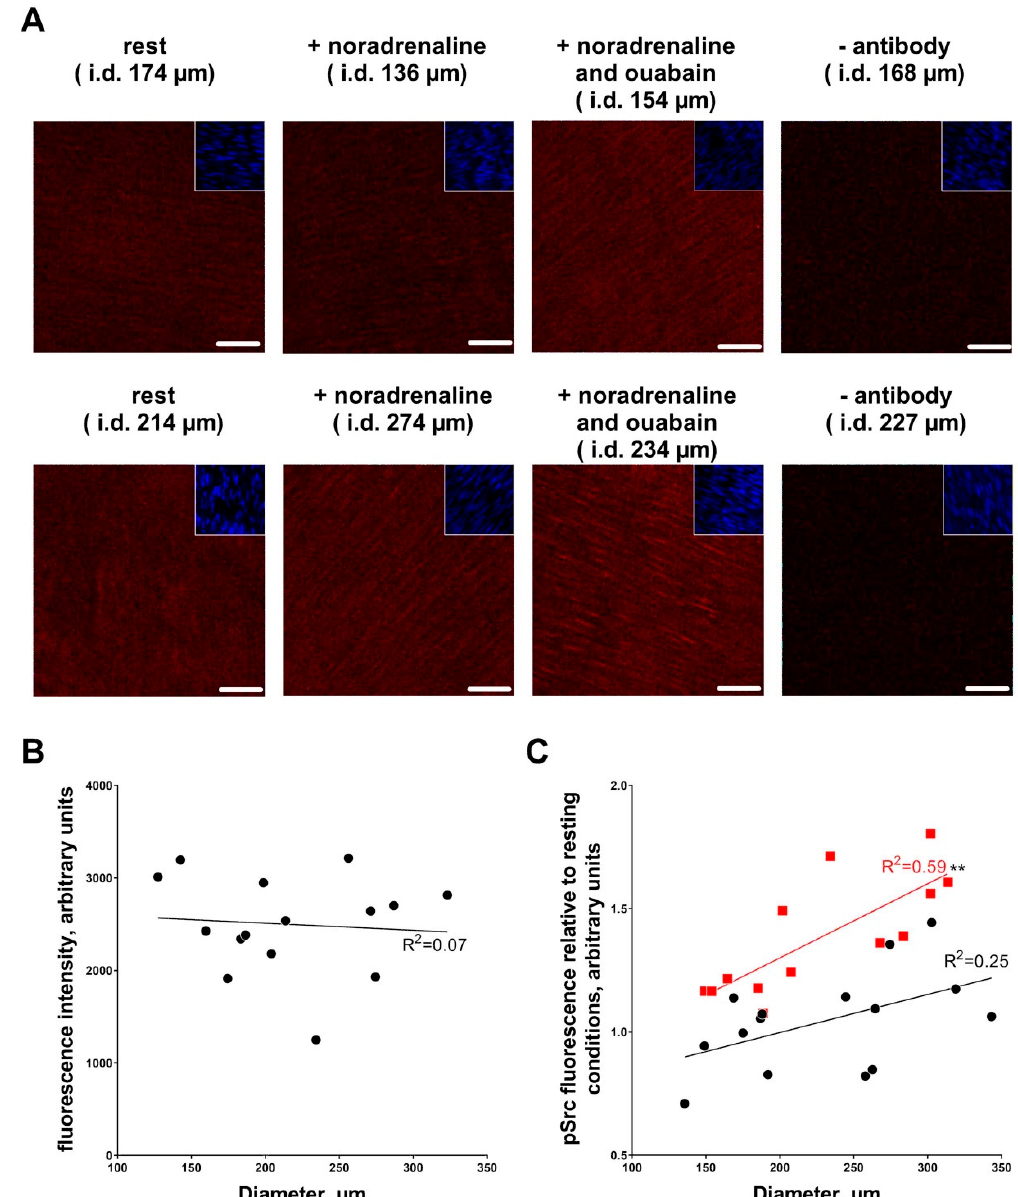
Figure 6. Ouabain-induced phosphorylation of Src kinase increases with arterial diameter. Arteries were fixed at resting conditions, after stimulation with 1 µM noradrenaline or incubation with 10 µM ouabain with the following 1 µM noradrenaline stimulation, as indicated in representative images (( A ); bars indicates 20 µm). A phosphorylated Src (pSrc) related fluorescence intensity was measured in smooth muscle layer in the vascular wall, as indicated by SYTO-16 based nuclei staining (inserts in images in ( A )). No difference in fluorescence intensity in arteries with different inner diameter was seen under resting conditions ( B ). In 15 experiments, the fluorescence intensity of the artery under resting conditions was compared to the intensity in the artery after noradrenaline stimulation with and without pre-incubation with 10 µM ouabain. There was no correlation between phosphorylated Src and inner diameter for noradrenaline stimulated arteries but in the presence of ouabain phosphorylated Src was significantly p < 0.01 (**) increased with arterial diameter. Linear regression quantifies goodness of fit with R 2 , as indicated by the graphs.